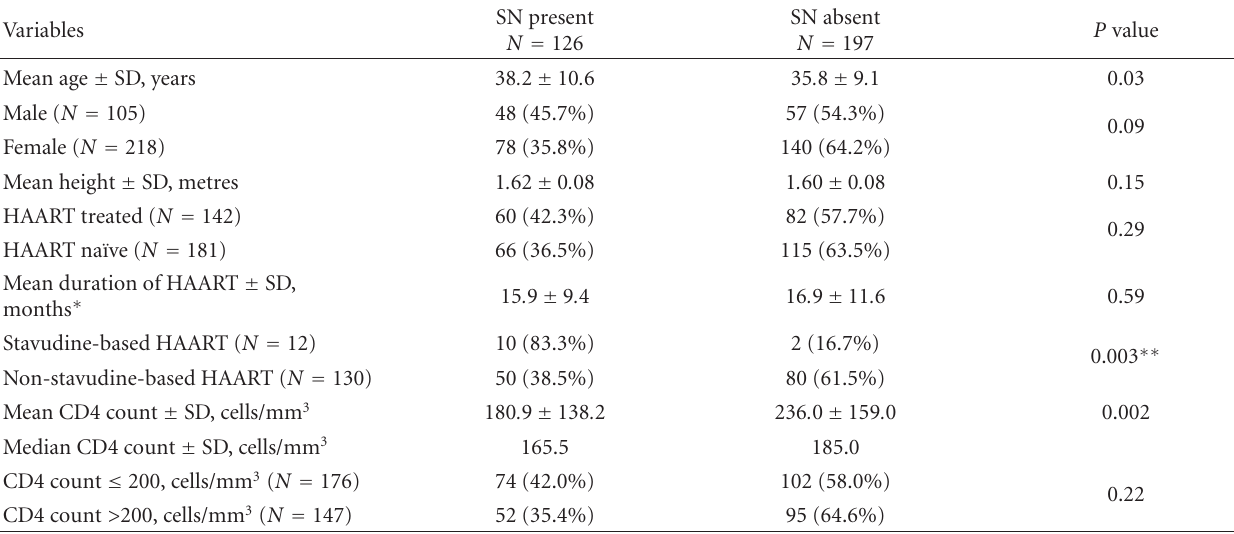
Table 2: Relationship between demographic and clinical variables and the occurrence of HIV-sensory